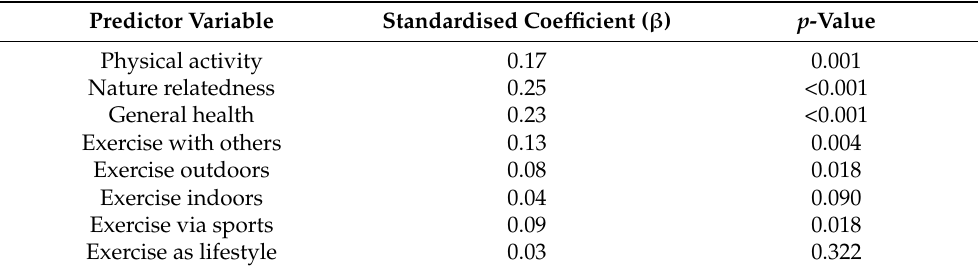
Table 5. Standardised regression coefficients for the relationship of predictor variables with psycho- logical